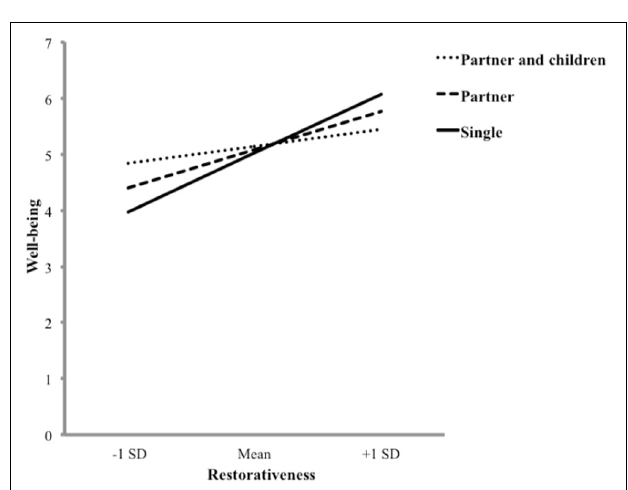
FIGURE 3 | Moderation of the effect of restorativeness on well-being by household